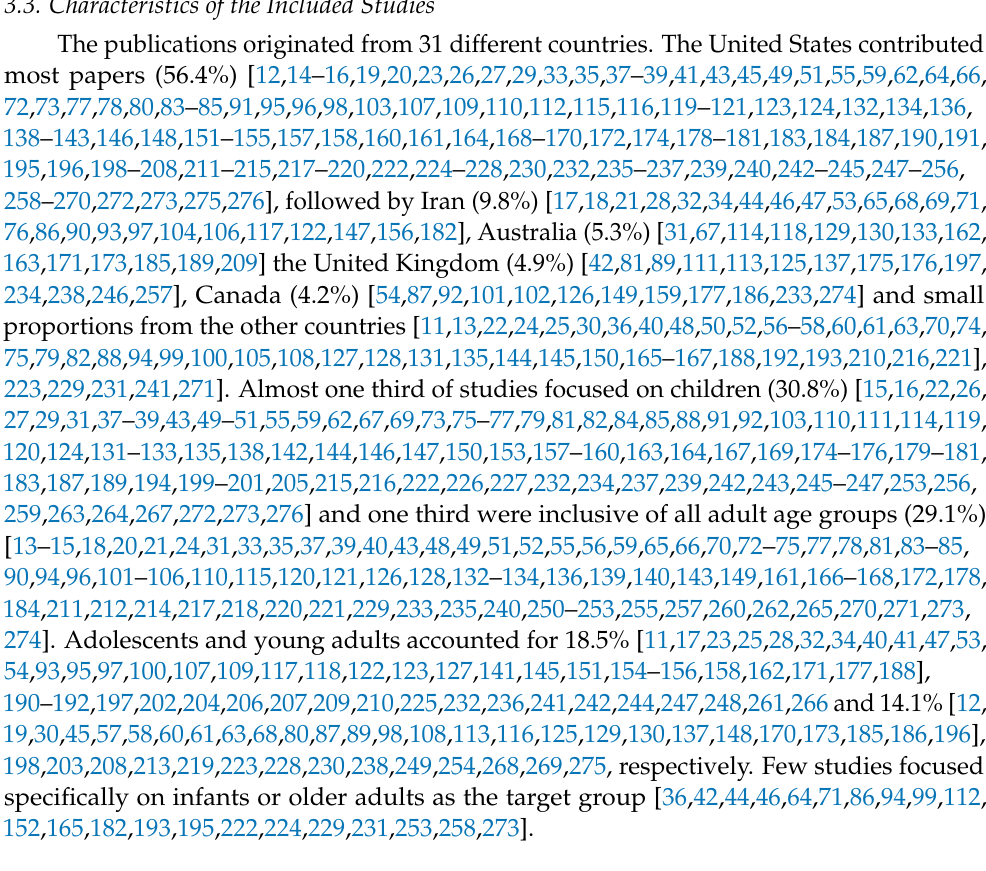
Figure 2. Trends in the number of publications on theory-informed healthy eating interventions between 2000 and 2020 .